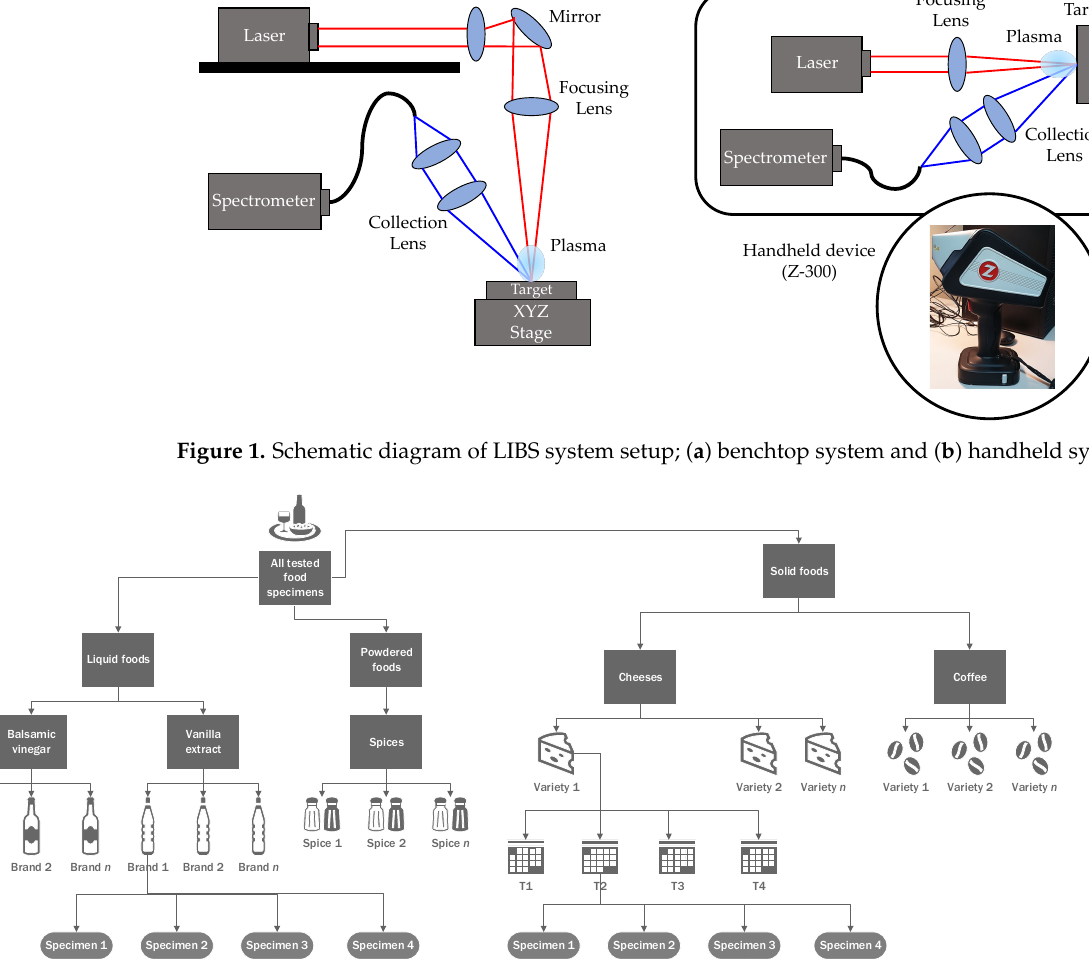
Figure 1. Schematic diagram of LIBS system setup; ( a ) benchtop system and ( b ) handheld system.